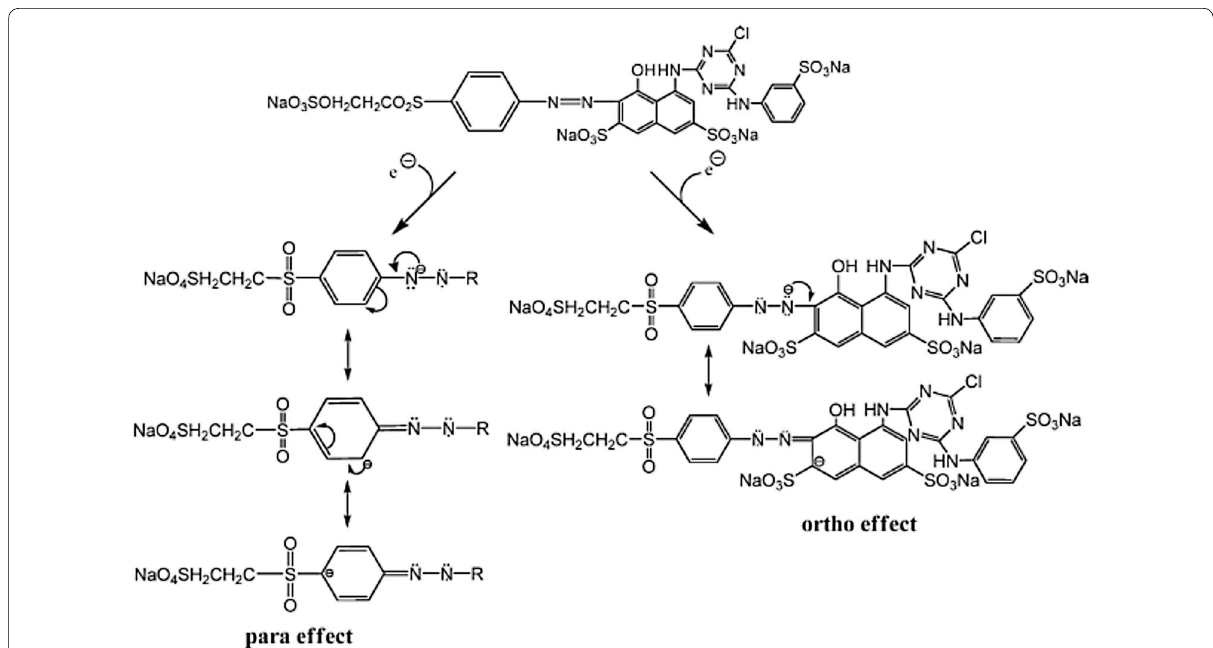
Fig. 3 Example presentation of resonance effect of RR198. The sulfonate at ortho and –SO 2 (CH 2 ) 2 SO 4 − at para to azo bond in RR198 are both high electronegativity substituents. These substituents may stabilize the negative charge present in the reduced intermediates, since azo dyes can be reduced through the inductive effect and resonance effect (Ref. to Fig. 5 in Hsueh et al.